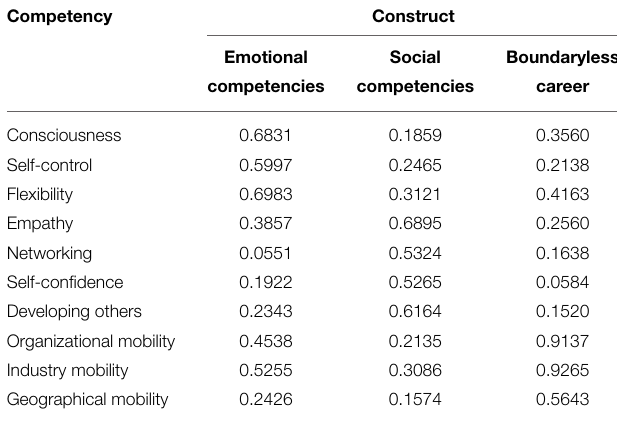
TABLE 4 | Crossloadings.